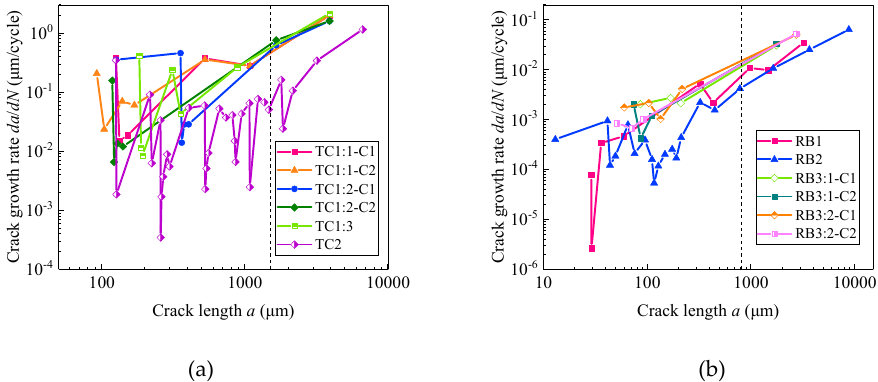
Figure 11. Curve of crack growth rate as function of crack length: ( a ) TC specimens; ( b ) RB specimens.